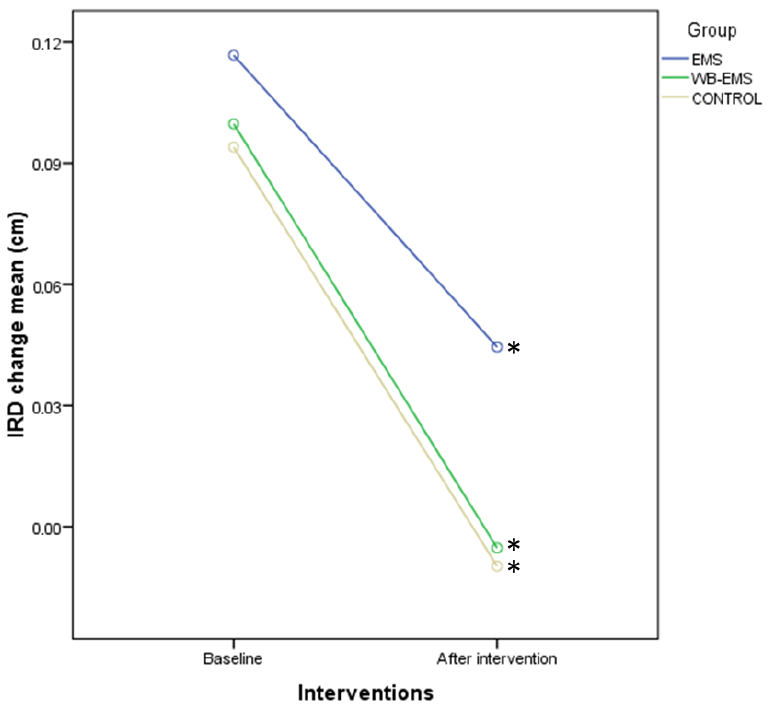
Figure 10. Linear graphs showing IRD change before and after interventions as well as intragroup comparisons among the EMS, WB-EMS, and control groups. Abbreviations: cm, centimeters; EMS, electrical muscle stimulation; IRD, inter-rectus distance; WB-EMS, whole body electrical muscle stimulation. * Intragroup comparisons showed statistically significant differences ( p < 0.05).